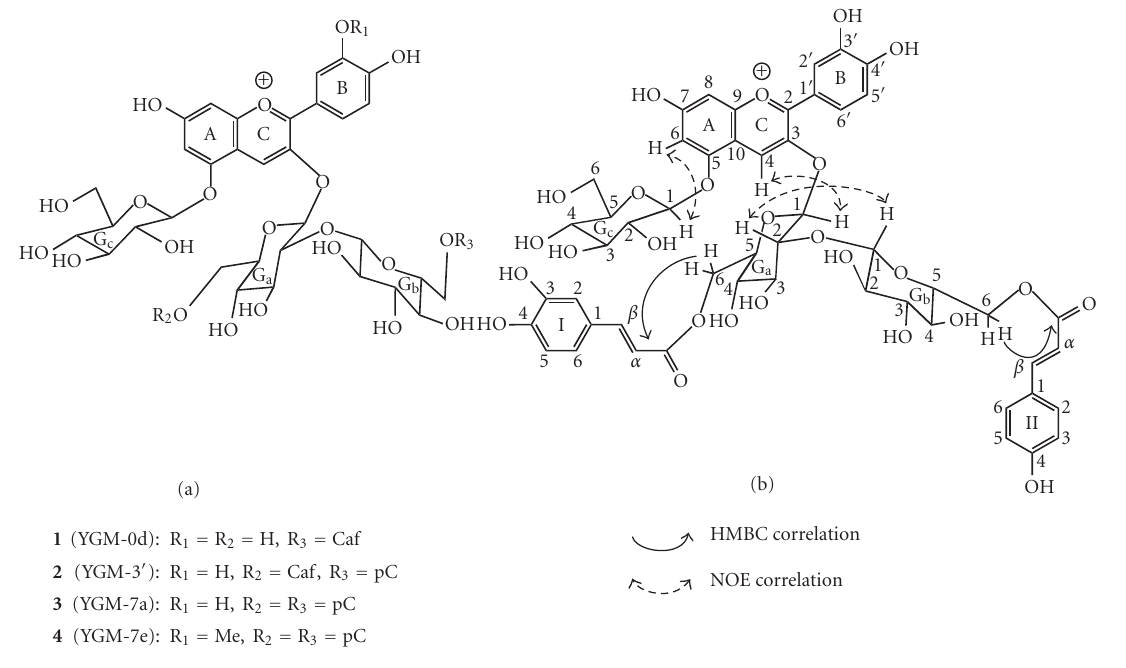
G a -2H (at δ H 3.95–4.06 ppm) and G a -2C ( δ C 81.54– 81.86 ppm) clearly shift to downfield more than G b -2H (at δ H 3.14–3.19 ppm) and G b -2C ( δ C 74.65–74.86